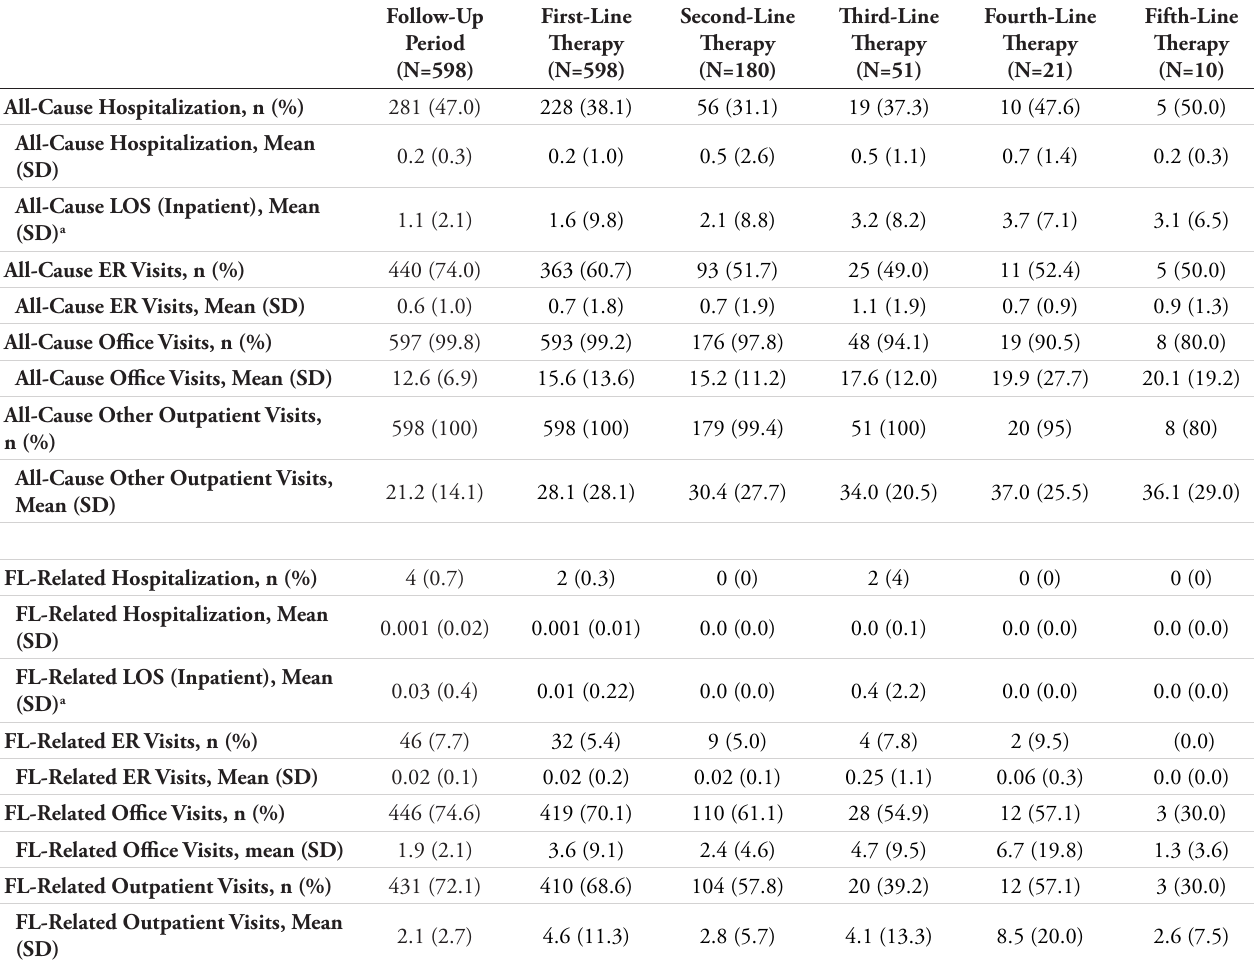
Table 5. Frequency of Annual Total Health Care Resource and Utilization for Patients with FL in the Follow-up Period and Lines of Therapy